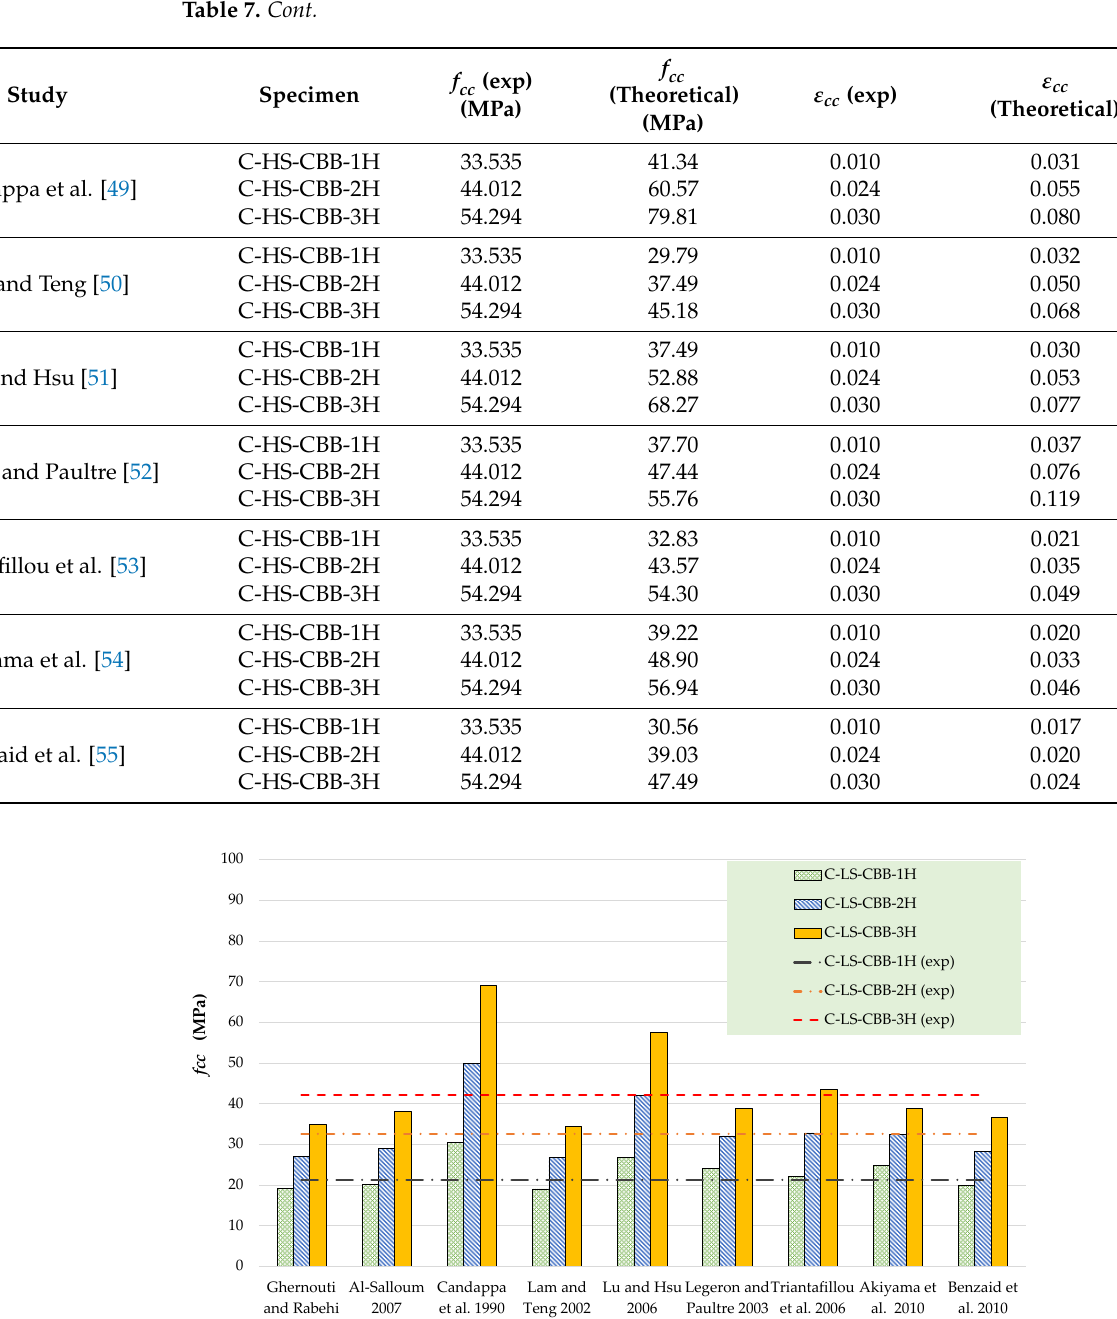
Figure 12. Comparison of strength for the Type-1 group [31 – 39].